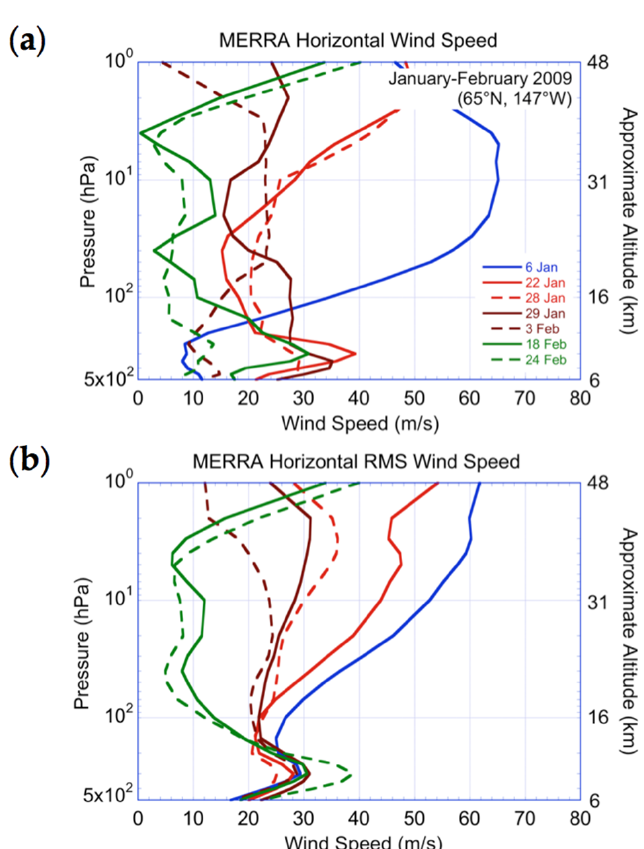
Figure 10. MERRA wind profiles for the seven nights plotted in Figure 5. The dates are indicated where “6 Jan” corresponds to the UT day 6 January 2009. ( a ) Winds over Chatanika; ( b ) RMS winds speed over an 800 km in radius circle centered at Chatanika.